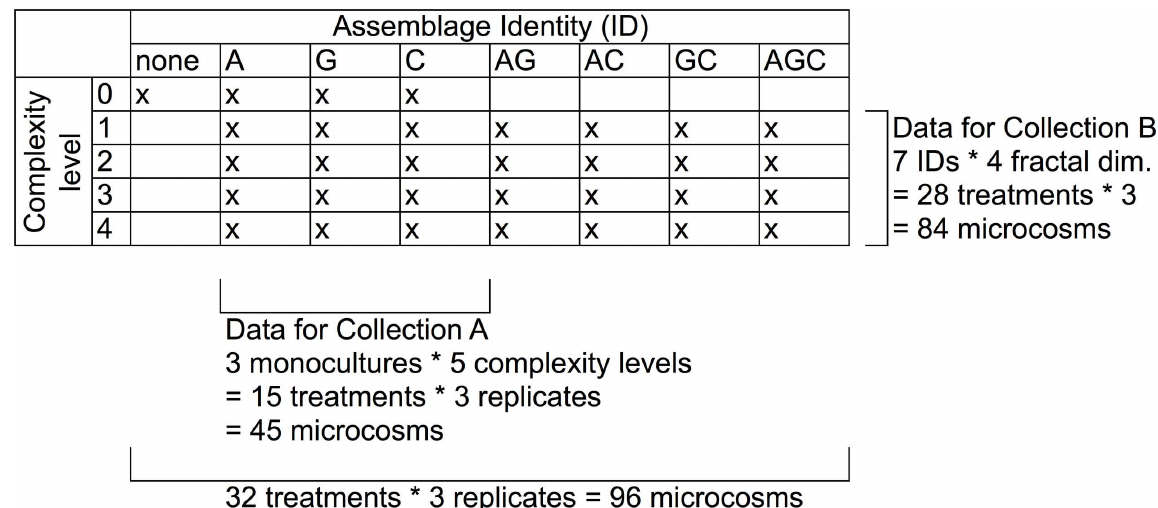
Fig 2. Experimental design of the experiment addressing the effect of complexity level and species combinations on three response variables. In total, there were five complexity levels includingstructure absent and levels 1–4 (created with plastic plants); and 7 assemblage identities(A is Asellus , G is Gammarus and C is Cyclops ). Our design was not fully factorial: only monocultures were run with structure absent. We therefore divided the dataset in two sub-sets and used two different collections of statistical models on them (collection A and